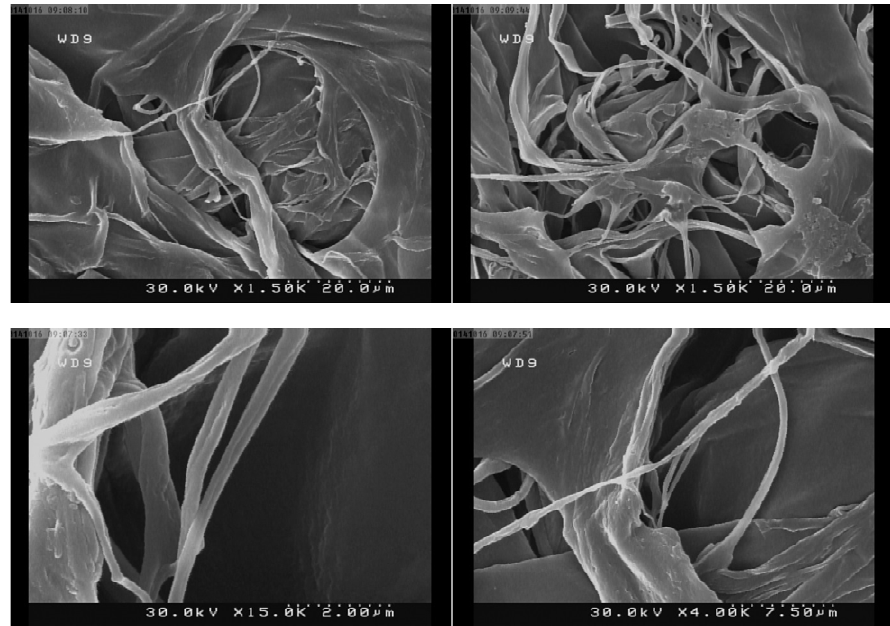
Fig. 3. Scanning electron microscope images of the CHX-CS